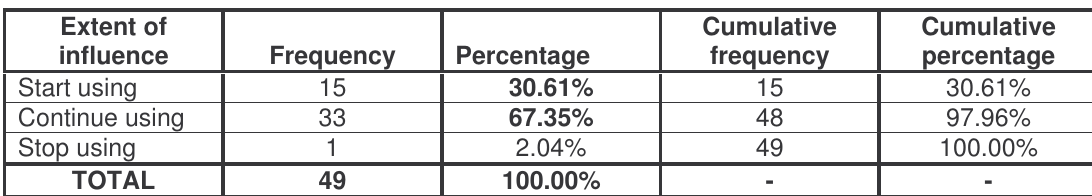
Likelihood of starting, continuing or stopping the use of the product life cycle concept for future product decision-making